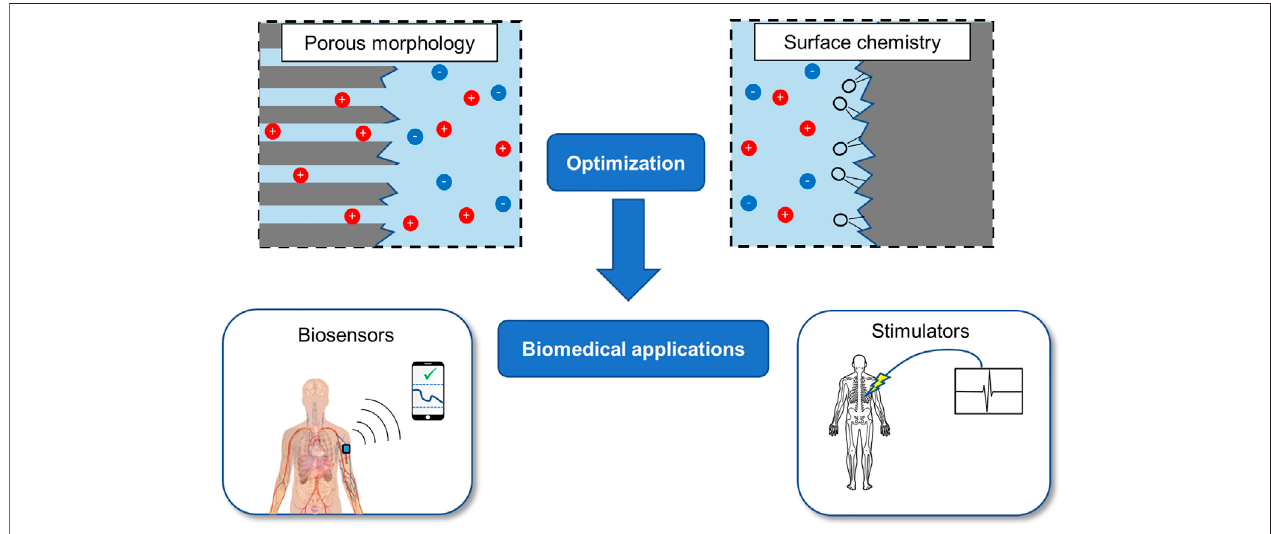
FIGURE 2 | A summary of the areas we have identi fi ed for the optimization of diamond-based supercapacitors, as well as the two major categories of implantable biomedical applications that could utilize the advantages of diamond.